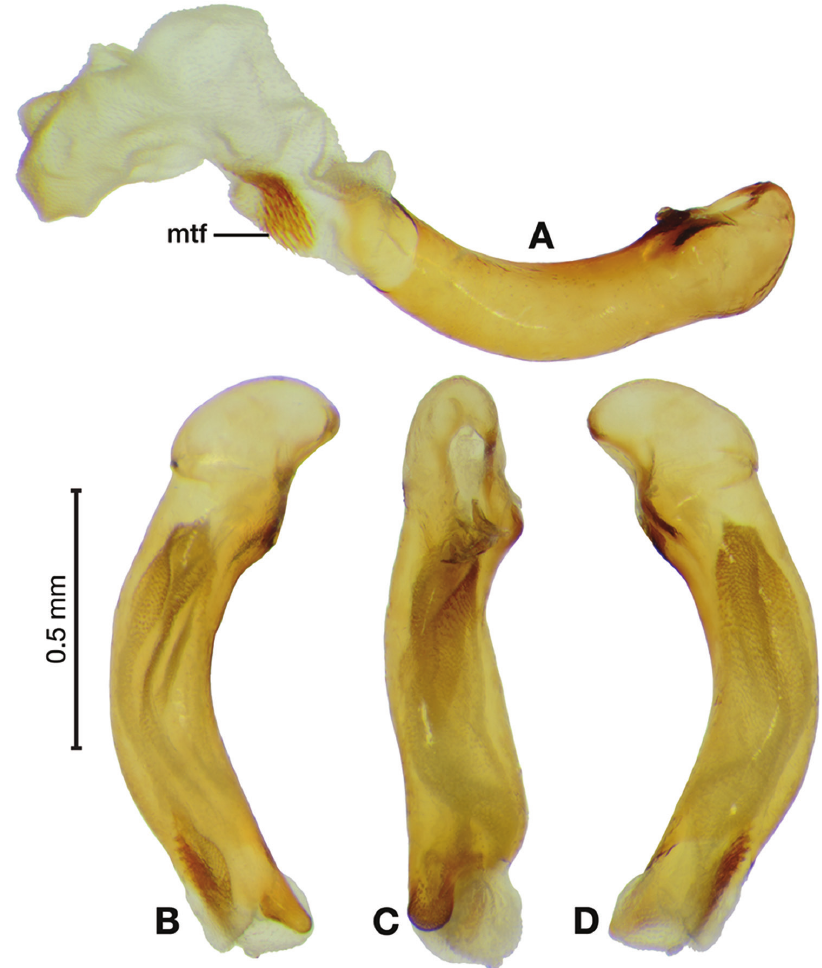
Figure 96. Digital images of male genitalia of Mochtherus luctuosus Putzeys. A left lateral aspect, endophal- lus everted B right lateral aspect C ventral aspect D left lateral aspect. Legend: mtf microtrichial